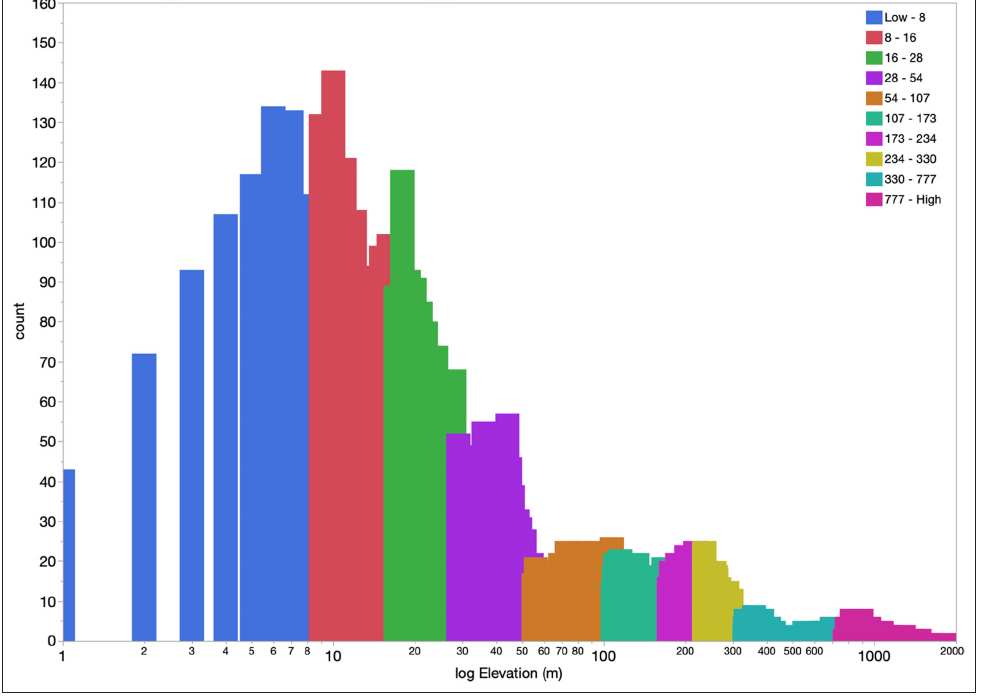
Figure 2 Distribution of elevational habitats available in North Carolina measured at 9,586 random points across the states. Colors show the 10 categories that each represent ~10% of the variation in available habitat. We used these categories to see if our camera samples were representative of the dimensions of a given habitat